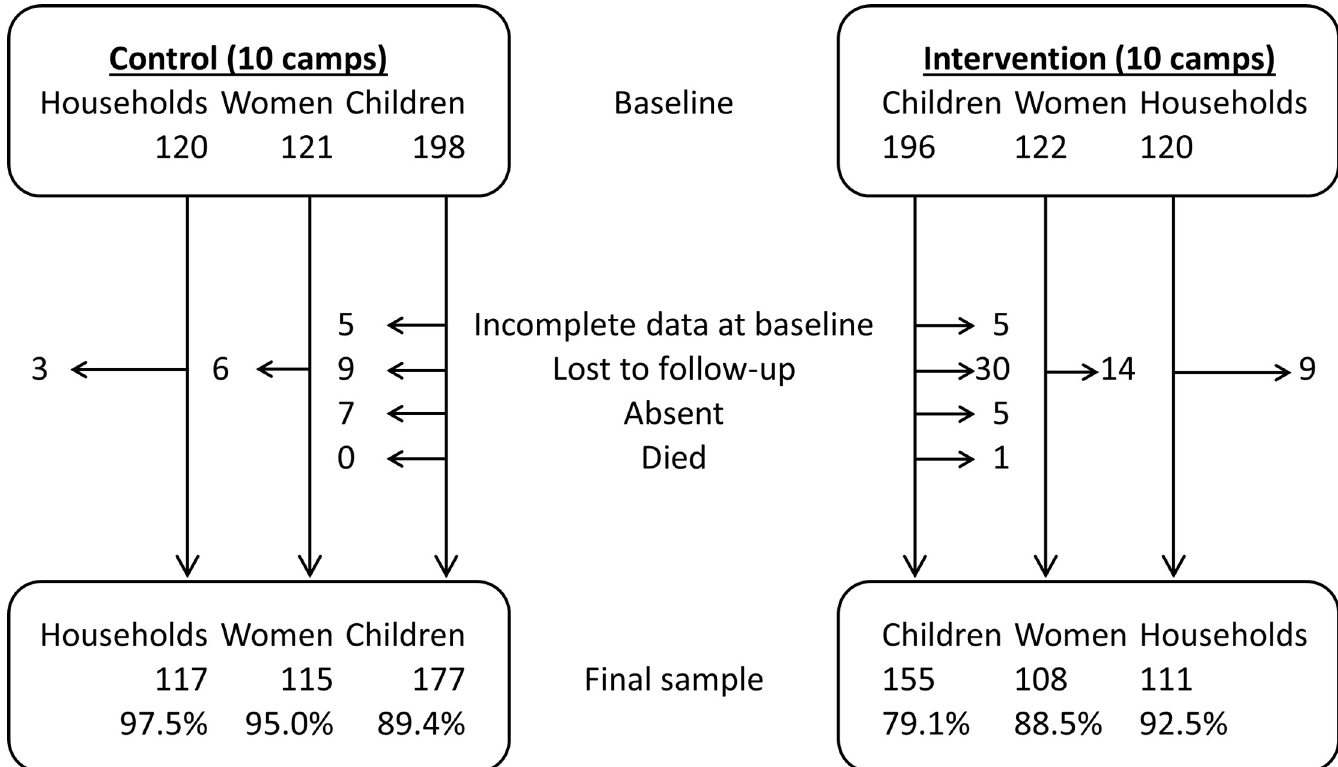
Fig 1. Household cohort participant flow